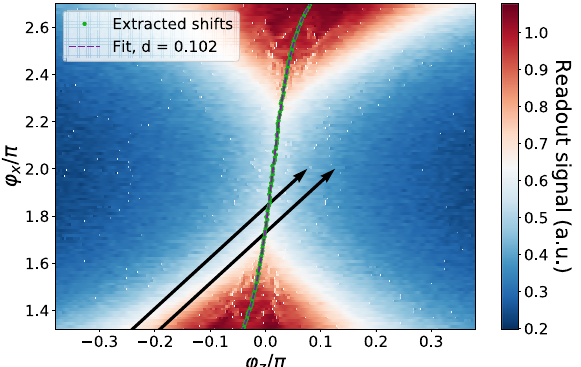
Fig. 3 Extraction of junction asymmetry from the experimentally measured dispersive resonator response, corresponding to the 0 ↔ 1 transition frequency of the CSFQ. The green circles are the extracted symmetry-point shifts, and the dashed purple line denotes the fi t to theory. The slanted arrows represent annealing paths used to probe the multilevel structure of the CSFQ, corresponding to two of the data-points in Fig. 5.